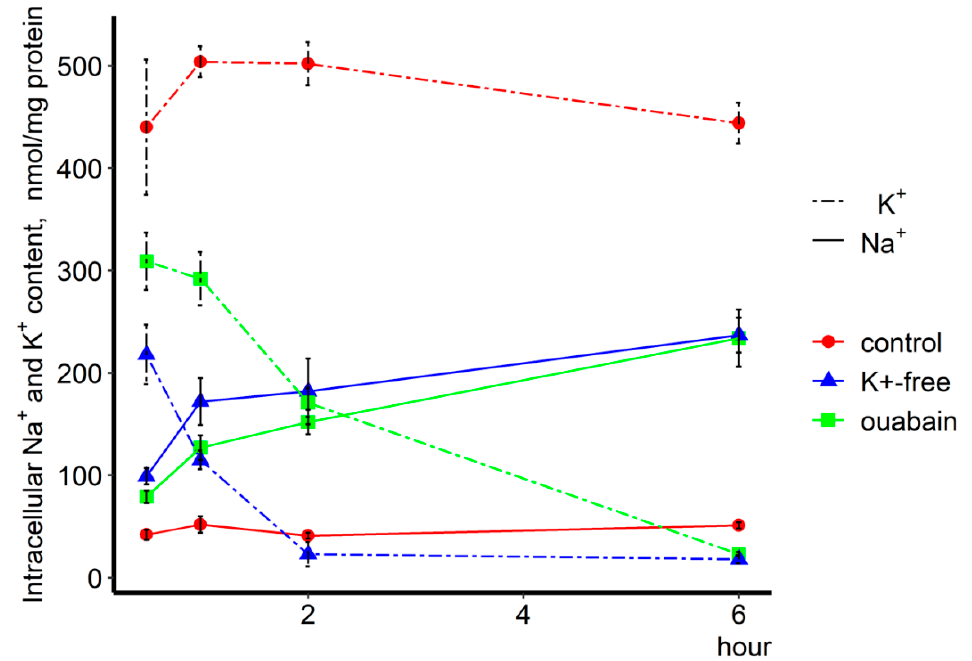
Figure 1. Kinetics of modulation of intracellular Na + and K + content by Na,K-ATPase inhibition in human umbilical vein endothelial cells. Cells were exposed to 3 µ M ouabain and K + -free medium for 0.5, 1, 2, and 6 h. The Na + i and K + i content in cells for each time point in the absence of treatment was taken as 100%. Means ± S.E. from three experiments performed in quadruplicate are shown.